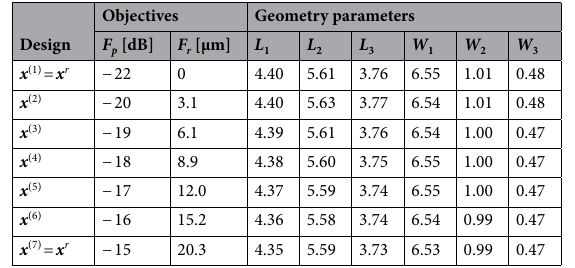
Table 1. Results of multi-criterial design with robustness evaluation for a bandpass filter of Fig. 5